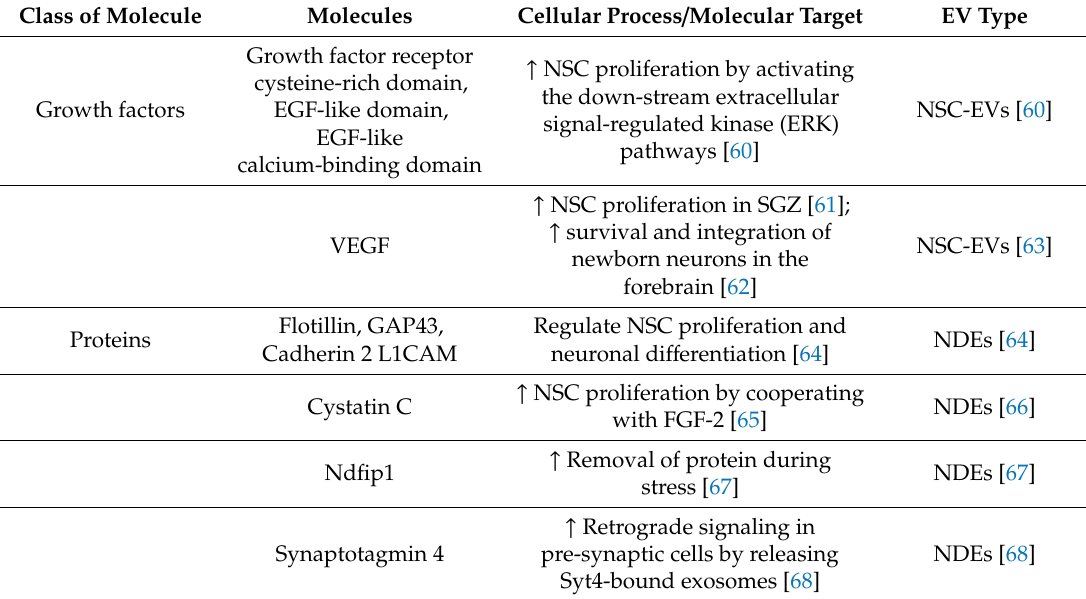
Table 1. List of di ff erent classes of pro-, anti-neurogenic and glia modulatory molecules found in extracellular vesicles derived from neural stem / progenitor cells-(NSC-EVs) and neurons (NDEs). Class of